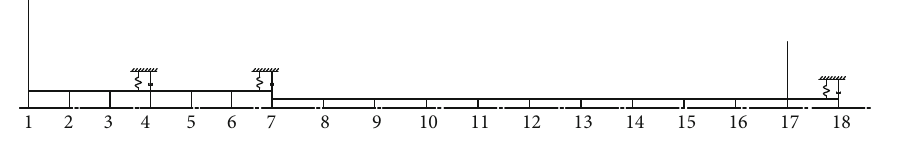
Figure 2: Finite element model of the low-pressure rotor.